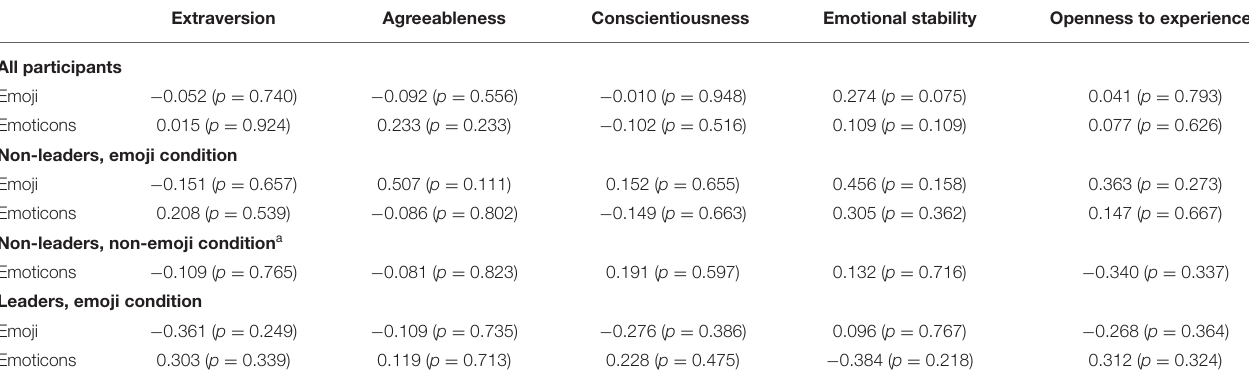
TABLE 5 | Personality